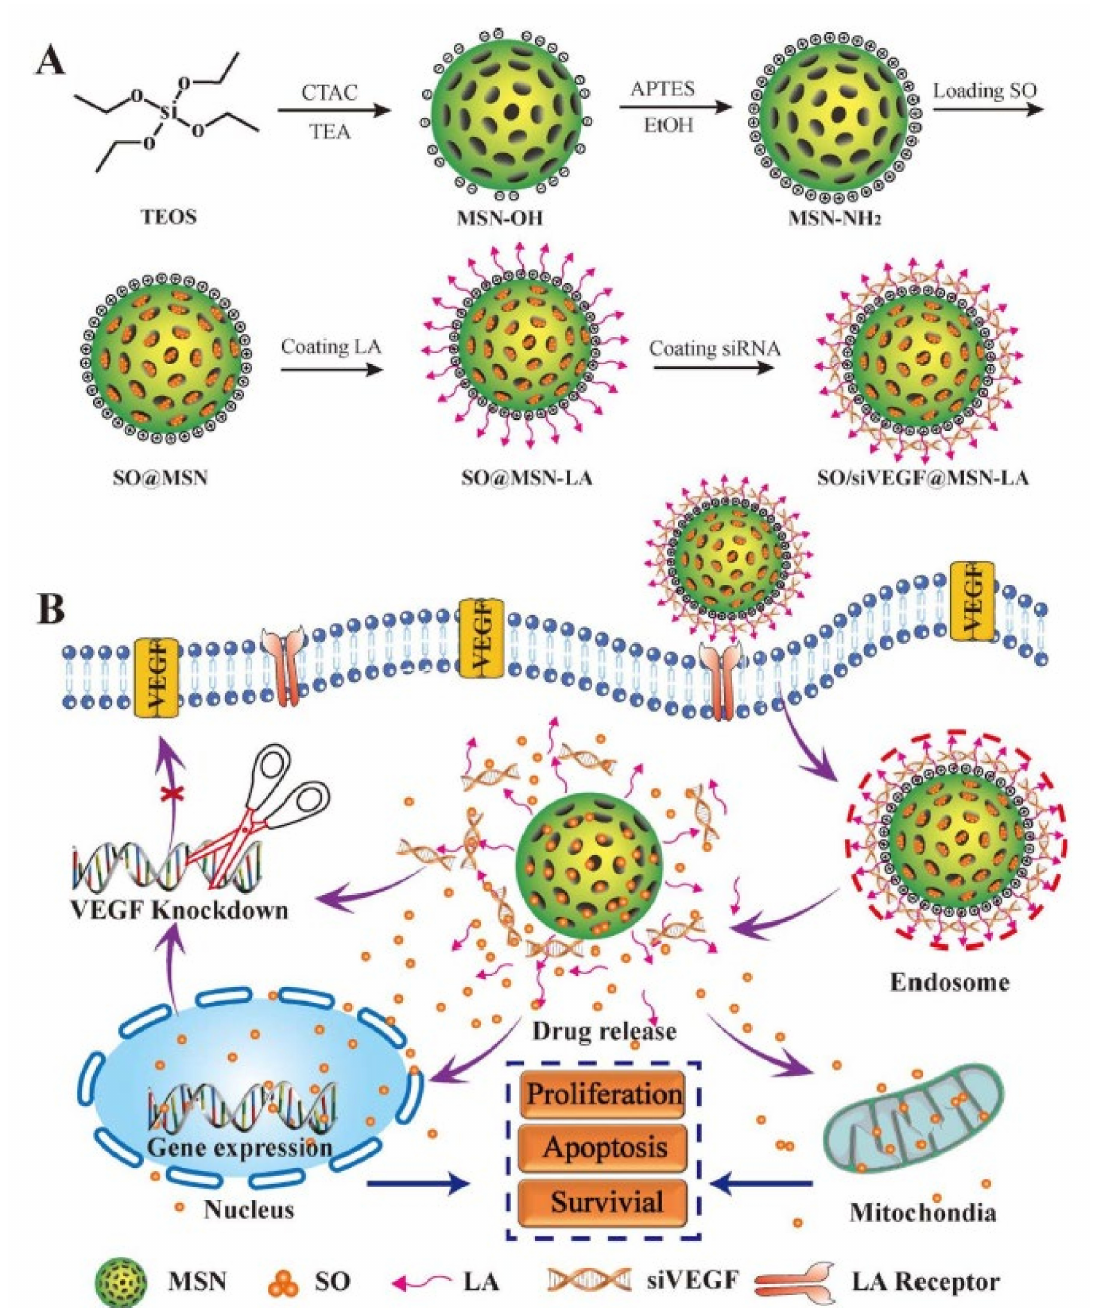
Figure5. ( A )SchematicrepresentationofthepreparationprocedureofSorafenibandvascularendothelial growth factor (VEGF) siRNA co-loaded modified MSNs; ( B ) Mechanism of the therapeutic effect. This image is used without modifications from [115]. Copyright © 2018, American Chemical